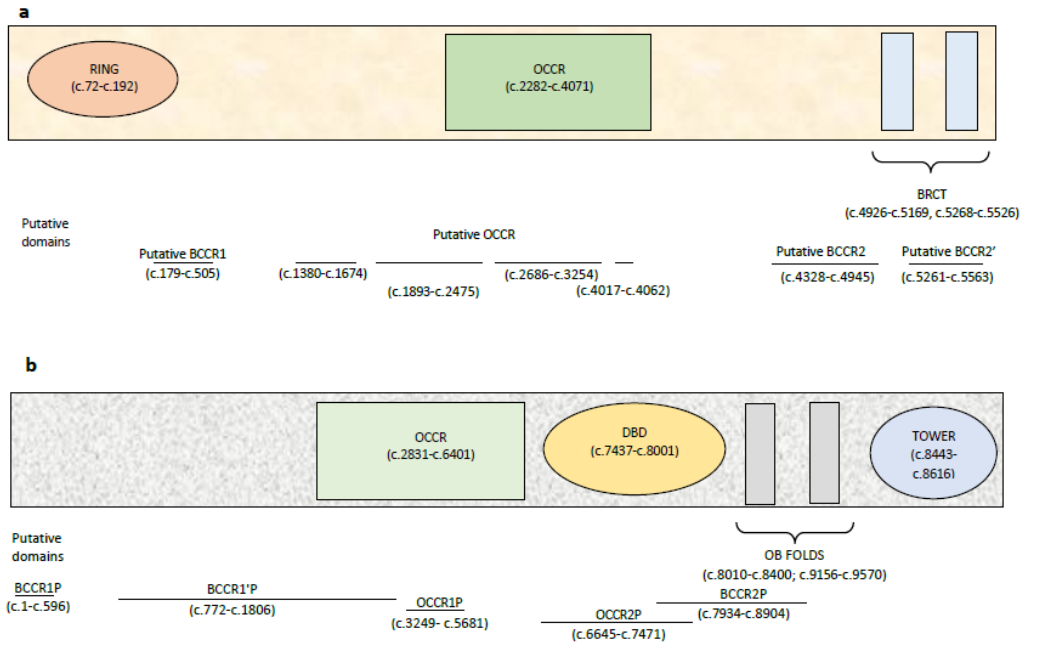
Figure 4. BRCA1 and BRCA2 cluster regions: ( a ) the classic regions of the BRCA1 gene are shown within the rectangle, while the putative domains, identified by black lines, immediately below. The different putative regions are identified by black lines; ( b ) the classic regions of the BRCA2 gene are shown within the rectangle, while the putative domains, identified by black lines, immediately below.